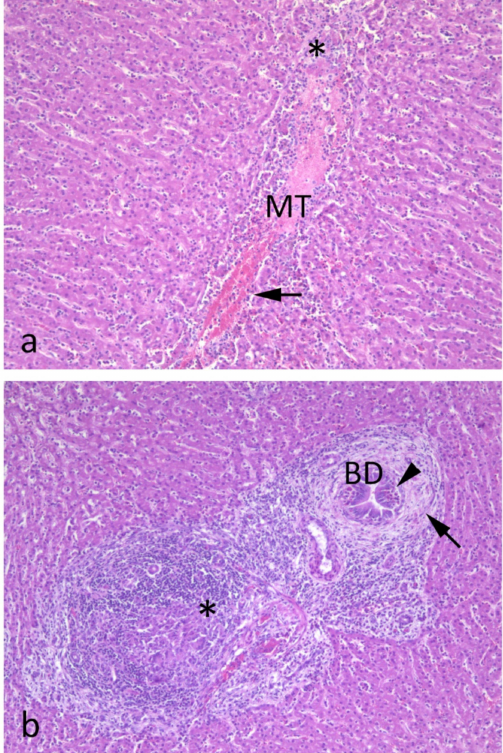
Figure 2. Histopathological changes of subacute fasciolosis. ( a ) Centrally placed is a migratory tunnel (MT) with destruction of the parenchyma, hemorrhage (arrow), inflammatory cells and fibrin (asterisk). ( b ) View of a triad. The bile duct (BD) is surrounded by connective tissue (arrow) and towards the duct epithelium there are eosinophils (arrowhead). The asterisk marks an area with giant cells and infiltration of mononuclear cells. There is also evidence of moderate bile duct